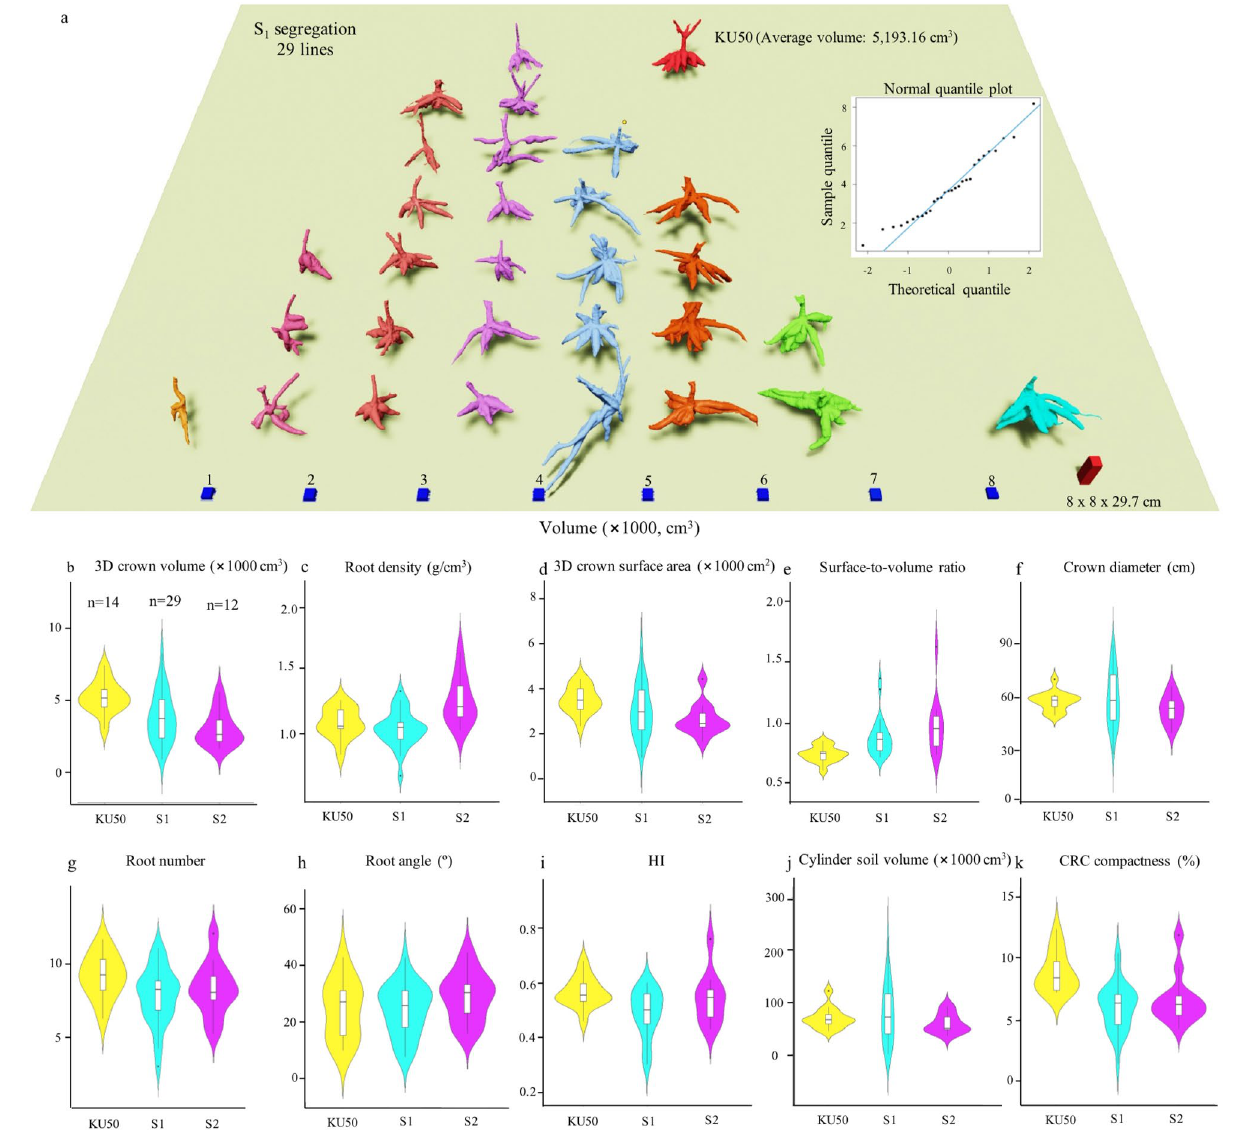
Figure 8. Phenotypic analysis using the 3D platform for cassava inbreeding populations. ( a ) 3D models representing 29 S 1 lines fitted into a normal distribution based on average 3D crown volumes, as supported by a normal quantile plot. KU50 as the S 0 progenitor is presented. Volume scales are indicated with blue boxes. A reference object is included. ( b–k ) Box and whisker plots and violin plots overlaid present phenotypic segregations of S 1 and S 2 inbreeding populations compared to KU50 for nine 3D traits and harvest